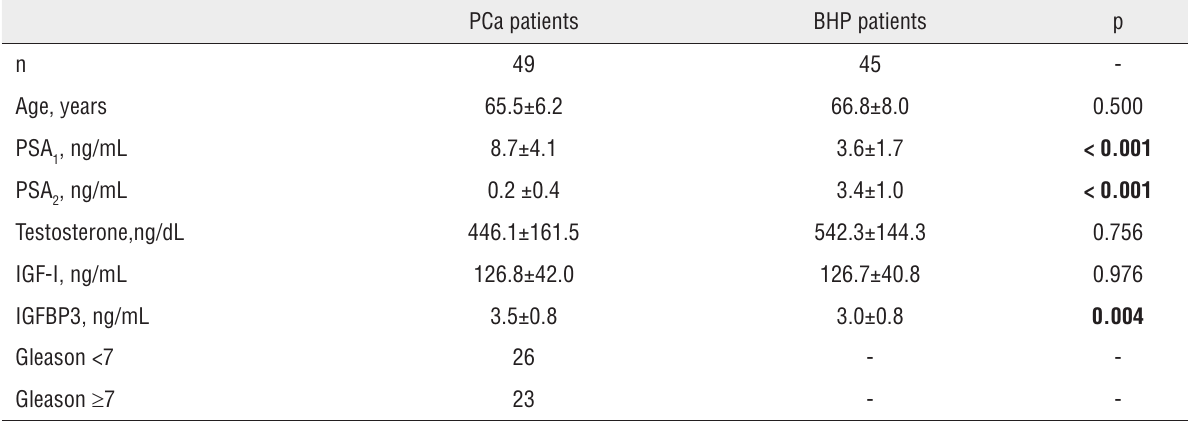
Table 1 - Clinical, laboratorial and pathological characteristics of PCa and BPH